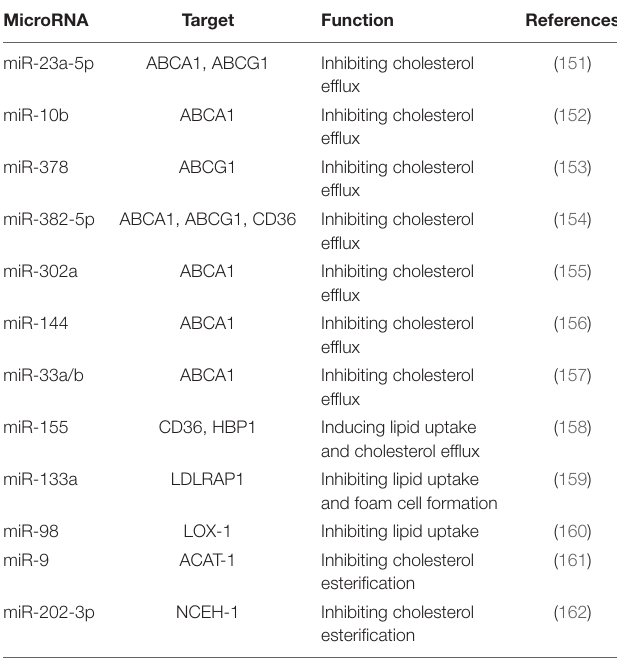
TABLE 1 | MicroRNAs in the regulation of foam cells and lipid accumulation. MicroRNA